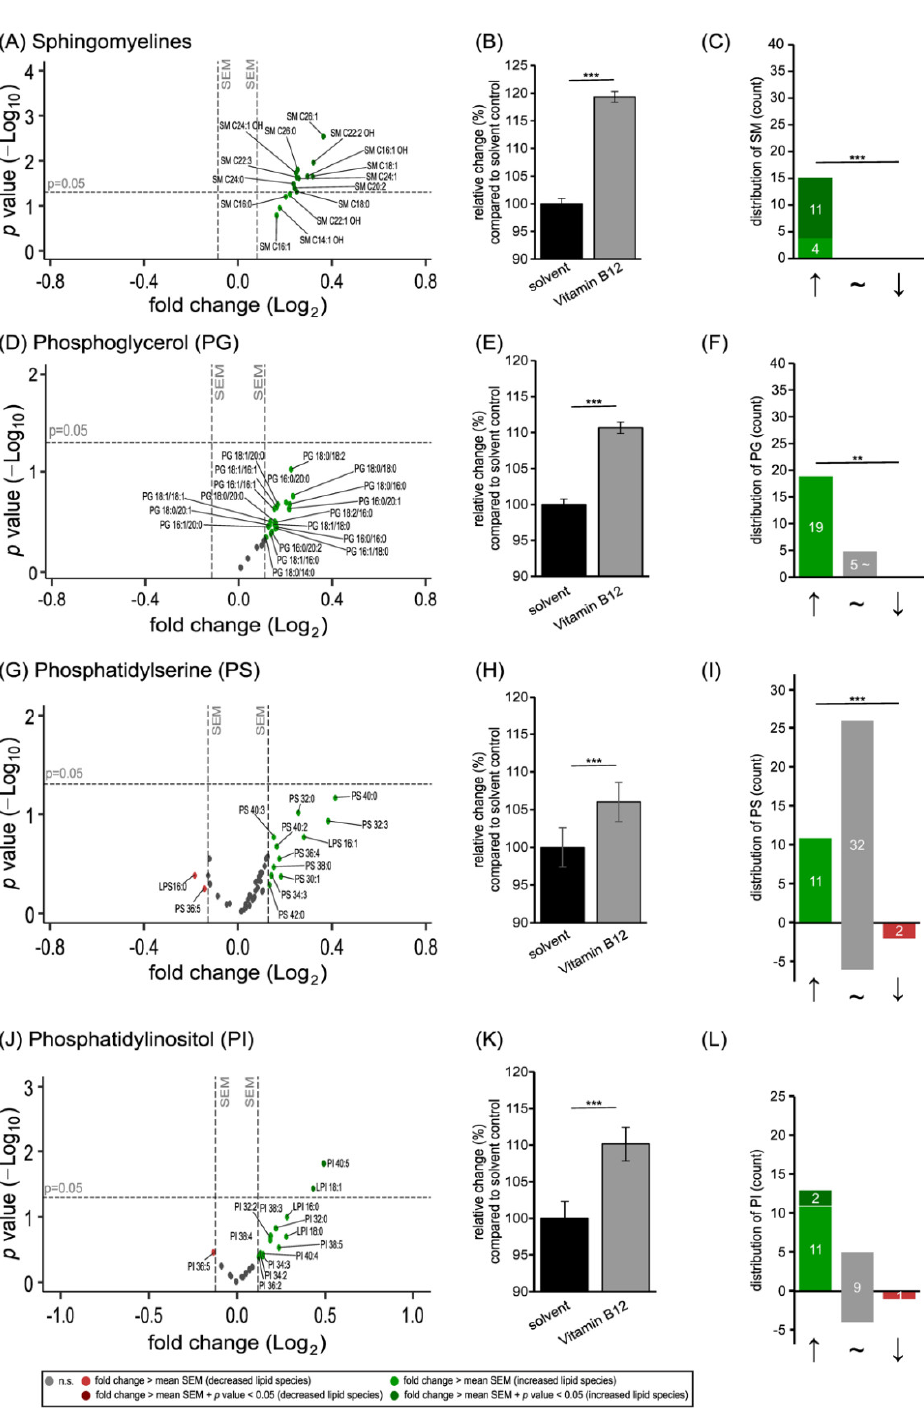
Figure 3. Effect of vitamin B12 treatment on further phospholipids, namely the sphingomyelin (SM, shown in ( A – C )), phosphoglycerol (PG, shown in ( D – F )), phosphatidylserine (PS, shown in ( G – I )), and phosphatidylinositol (PI, shown ( J – L )) species. SH-SY5Y cells treated with vitamin B12 compared to cells treated with the solvent control (HPLC water). In each of the volcano plots ( A , D , G , J ), the particular phospholipid species with its fold change (x-axis) in relation to its p -value (y-axis) is shown as a dot. Plots are structured as in Figure 1. ( B , E , H , K ) The bar chart shows the relative fold change of the particular phospholipid species after vitamin B12 treatment, in comparison to treatment with the solvent control. ( C , F , I , L ) Distribution of the particular phospholipid species, structured according to the amount of increased, unchanged, or decreased species. Statistical significance was set as ** p ≤ 0.01 and *** p ≤ 0.001.